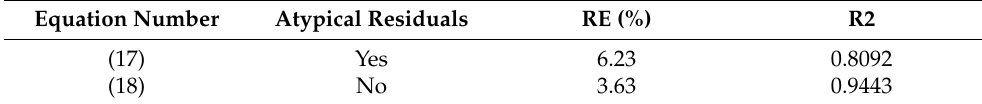
Figure 25. The Vout in the different frequencies tested in prototype NP2. We use Statgraphics to compare the value of the R2 with a unique model for each frequency and all collected data. The values of R2 are 0.8458, 0.9291, 0.9309, 0.9303, and 0.9381 for 480 kHz, 490 kHz, 500 kHz, 510 kHz, and 520 kHz, respectively. Despite these values of R2, we observe graphically that the models do not represent well enough the values we have obtained. We test two possibilities: (I) we eliminate the initial moisture values before the trend reversal occurs (until 45.3% of soil moisture), and (II) we use two models. Table 9 represents the equation of the models (Equations (19)–(23)), the values of R2 and RE for (I). Meanwhile, Table 10 presents the same information for (II) (Equations (24)–(33)). In (I), the values of R2 are slightly lower than the second model of the previous case. In (II), we observe that the first model has a reduction in the value of R2, and the second model has an increase in R2. In (I), we lose the upper values in the range of use. However, we will have minor errors, and the lost values are in conditions where irrigation should not be managed in most agricultural fields. If we observe the values of the REs in Tables 9 and 10, the highest is in 480 kHz for the two cases, (I) and (II). In (II), the RE is